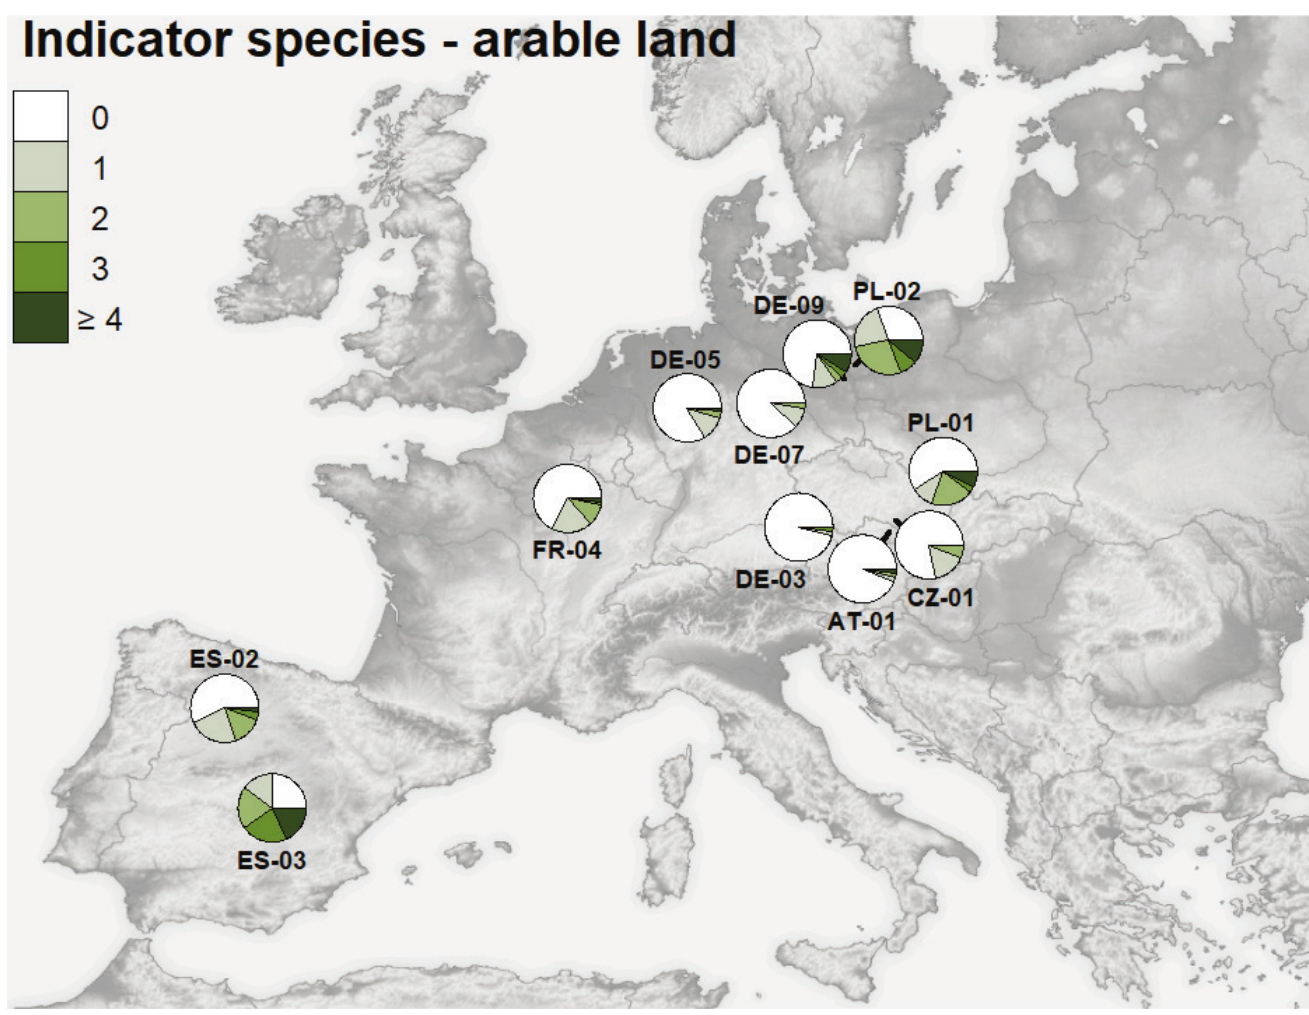
Figure 8. Percentage of transects with different numbers of arable indicator species in dominantly arable regions in 2016. The map shows the percentage of transects with 0, 1, 2, 3 and ≥ 4 indicator